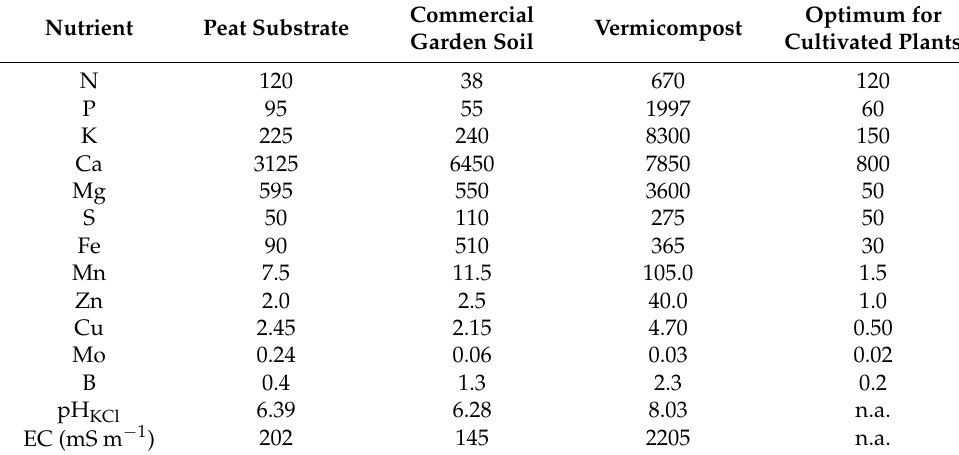
Table 1. Concentration of plant-available mineral nutrients (mg L − 1 dry substrate) in substrate and vermicompost samples used in the present study in comparison to approximate optimum concentrations in substrate for cultivated plants